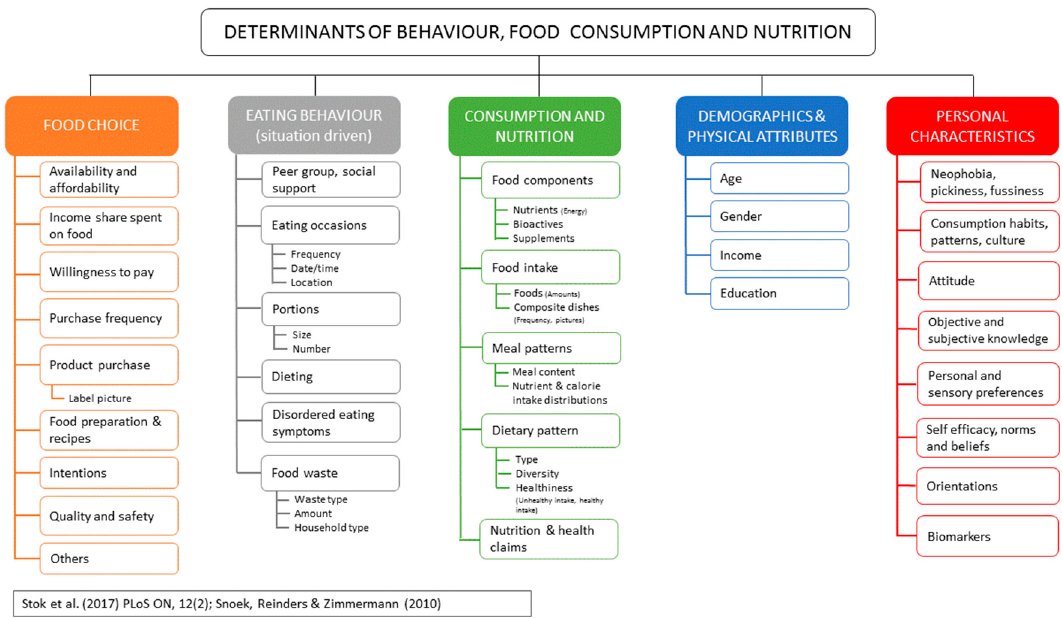
Figure 3. Overview of the determinants of dietary behavior, food consumption and nutrition, including food components. Adapted from Stok et al. (2017) [47] undertaken as part of the Determinants of Diet and Physical Activity (DEDIPAC) Knowledge Hub.